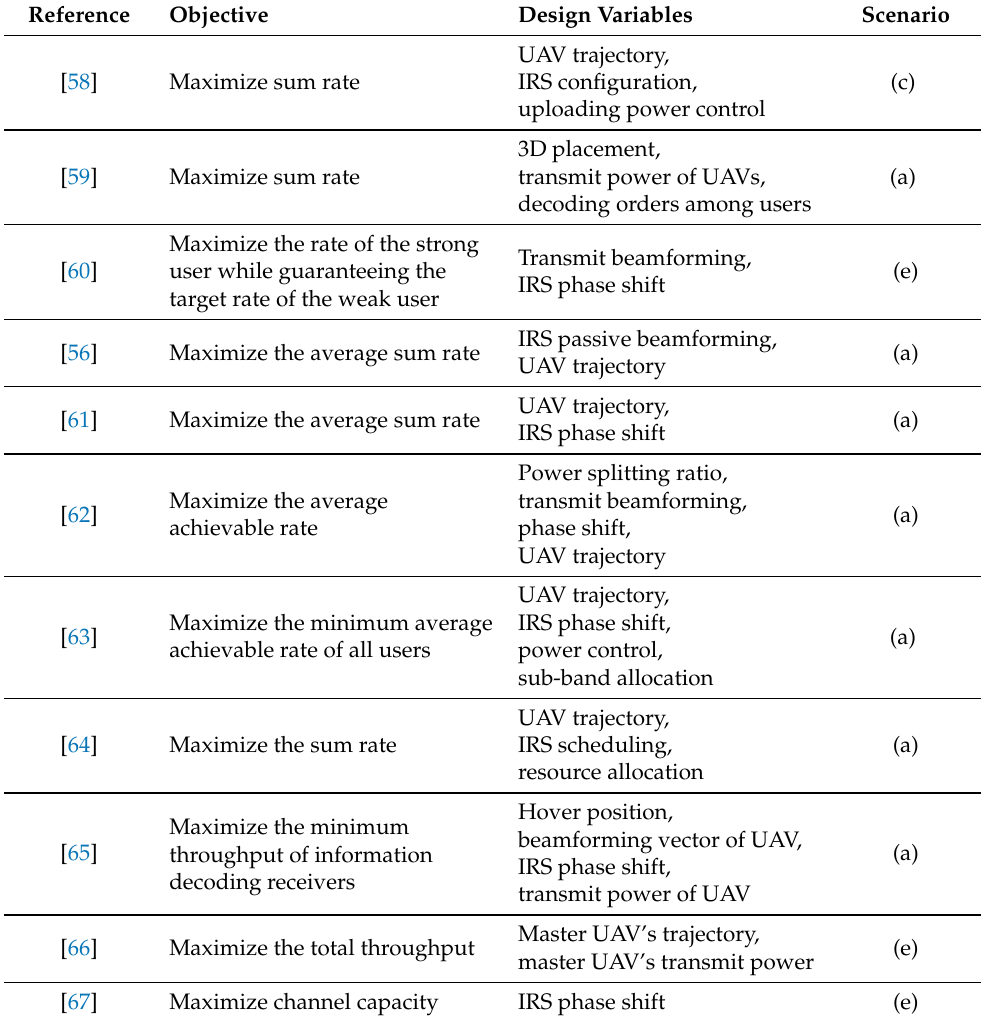
Table 1. Summary of previous works relevant to improvement of spectral